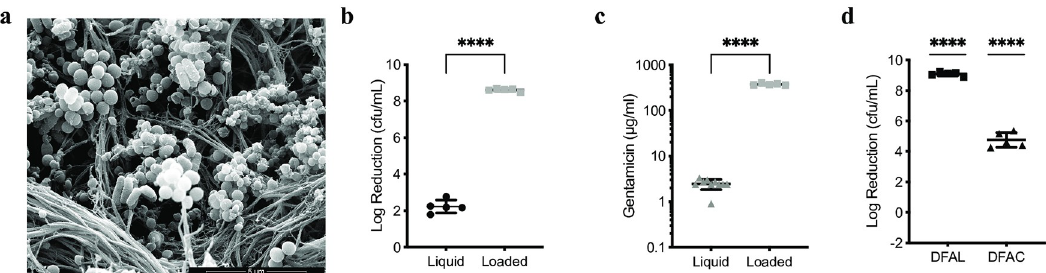
Fig 4. Biofilms were grown in the IVM models using strains isolated from the diabetic foot tissue. These were exposed to either liquid gentamicin and gentamicin loaded CSB or gentamicin loaded CSB only. Increased log reductions were again observed after exposure of biofilms to gentamicin loaded CSB. (a) SEM of a polymicrobial biofilm in the IVM model grown from strains isolated from DFAN. Both rods and cocci can be seen in the matrix. Log reductions in biofilm derived from DFAN upon exposure to gentamicin as a liquid or loaded into CSB were 2 and 8 respectively (P < 0.0001), consistent with data in Fig 2(b) and this corresponded to increased gentamicin in the models after exposure to gentamicin in CSB (P < 0.0001) (c). Biofilms derived from samples DFAL and DFAC were also grown in IVM models and exposed to gentamicin loaded CSB resulting in eradication of the biofilm or a 5 log reduction respectively (P < 0.0001) for gentamicin loaded compared to unloaded beads